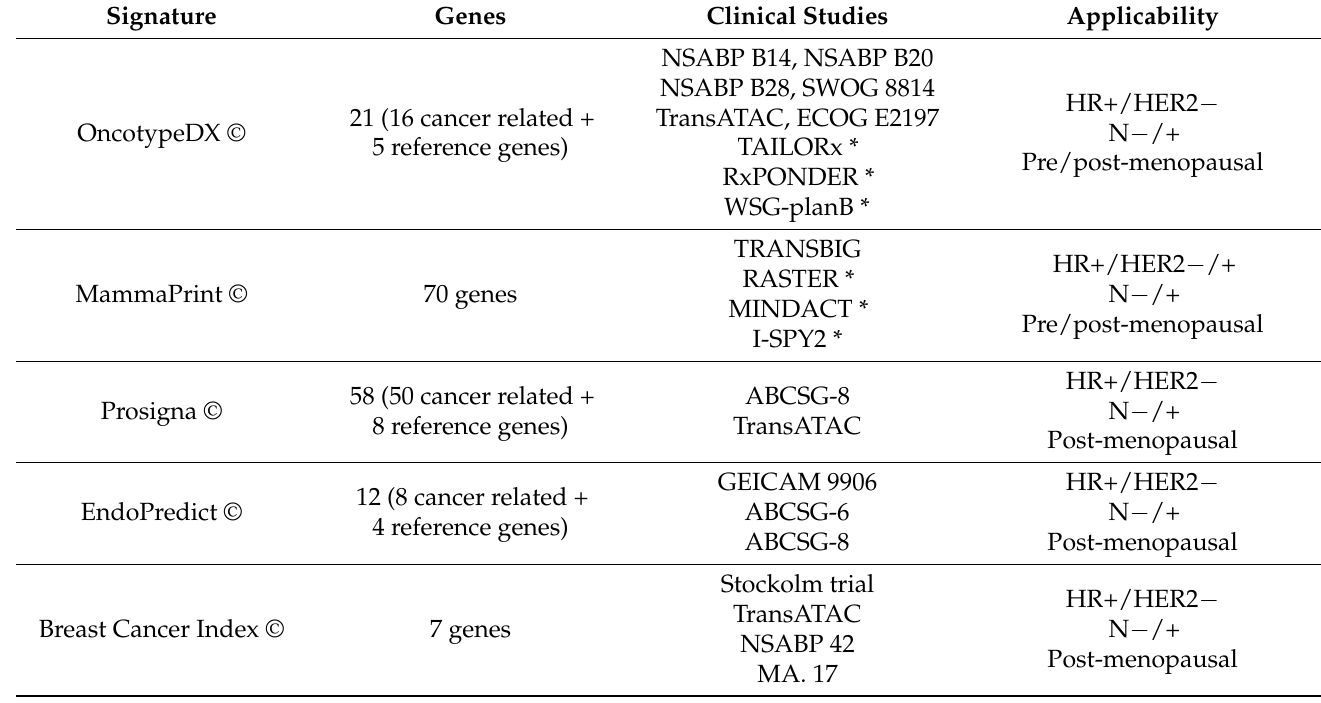
Table 1. Main characteristics of the five commercially available gene expression signatures.